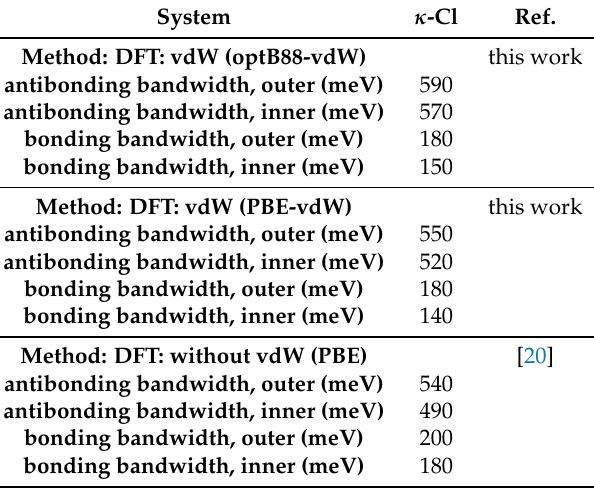
Table 6. Direct antibonding and bonding bandwidths of κ -Cl defined as the width at the Γ point obtained from ab initio calculations that include vdW interactions (this work), or without them ([20]). System κ -Cl Ref. Method: DFT: vdW (optB88-vdW) this work